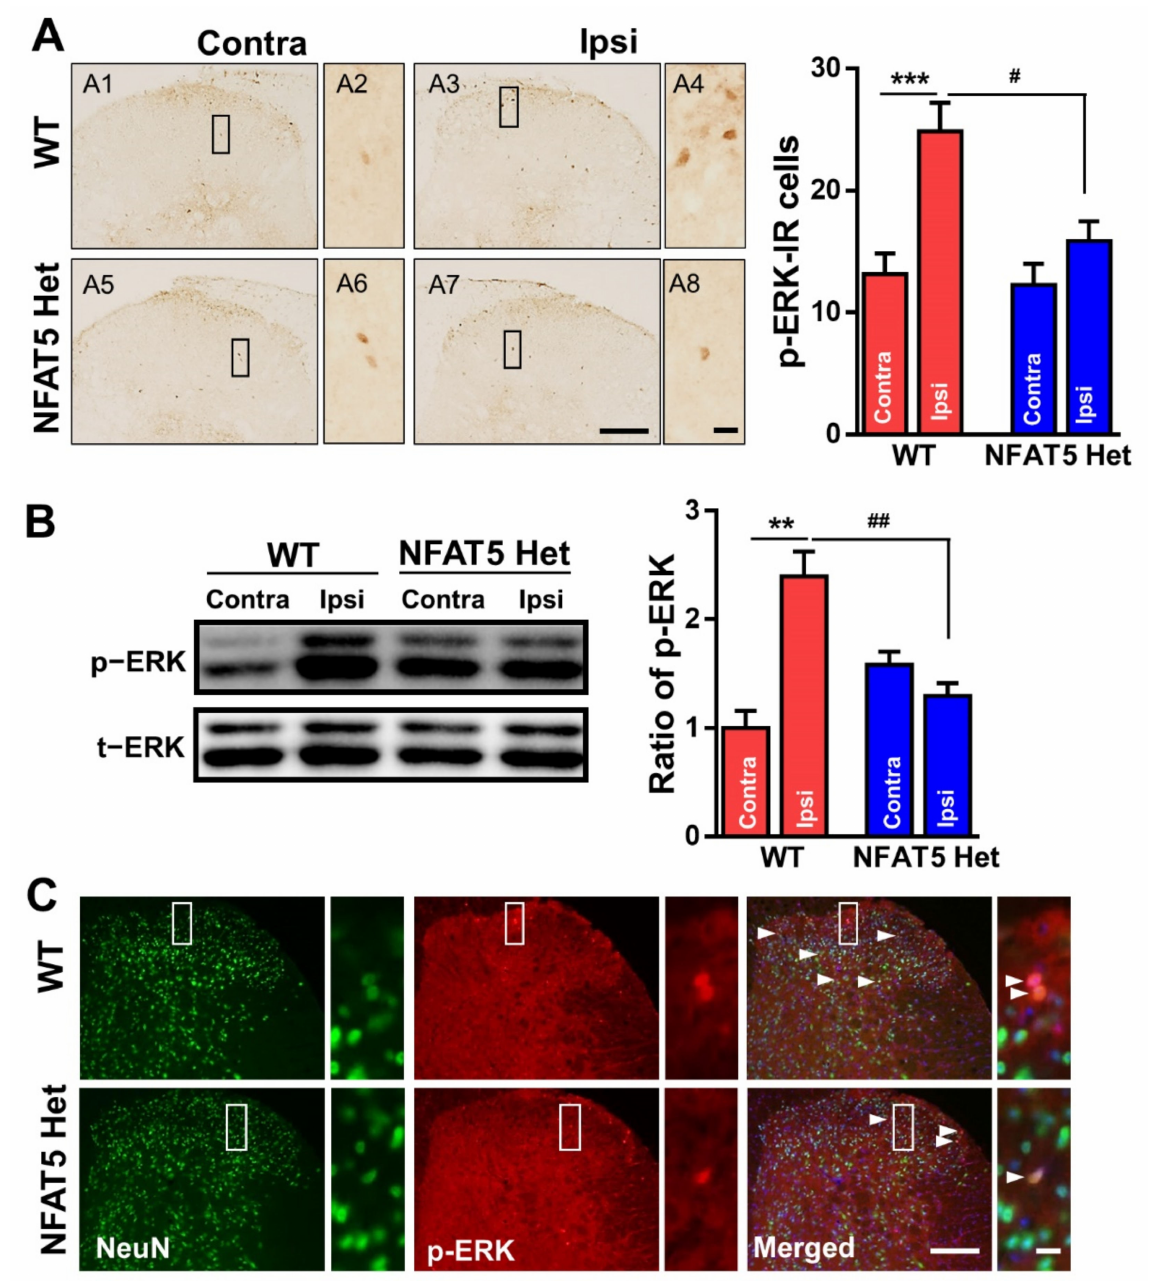
Figure 4. Formalin-induced phosphorylation of ERK in the spinal dorsal horns of WT and NFAT5-Het mice. ( A ) At 1 h post-formalin injection, the levels of ERK phosphorylation in the spinal dorsal horns of WT and NFAT5-Het mice were assessed by immunostaining with anti-p-ERK antibody. Scale bar: 50 µ m (left), 20 µ m (right). The numbers of p-ERK- immunoreactive (IR) cells were quantified in contralateral (contra) and ipsilateral (ipsi) sides of the spinal dorsal horns in WT and NFAT5-Het mice. Data are expressed as the means ± SEMs (one-way ANOVA with Tukey’s post-hoc test, *** p < 0.001 vs. WT contra, # p < 0.01 vs. WT ipsi; n = 7). ( B ) The expression levels of p-ERK in the spinal cord (lumbar [L] 4–6) were also validated by Western blot analysis. Band intensities expressed as the ratio of p-ERK normalized to total (t)-ERK. Data are expressed as the means ± SEMs (one-way ANOVA with Tukey’s post-hoc test, ** p < 0.05 vs. WT contra, ## p < 0.01 vs. WT ipsi, n = 5). ( C ) The tissues in (A) were further co-stained with anti- p -ERK and anti-NeuN antibodies. Arrow heads indicate p-ERK/NeuN-positive cells. Scale bar: 50 µ m (left), 20 µ m